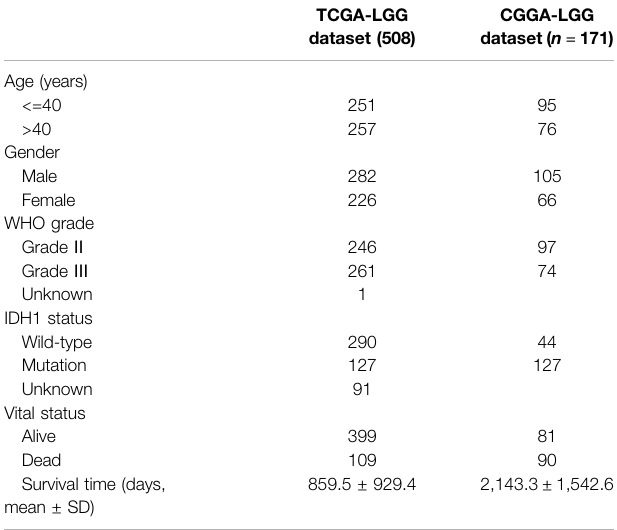
TABLE 1 | Summary ofclinical characteristics ofthe lower-grade glioma